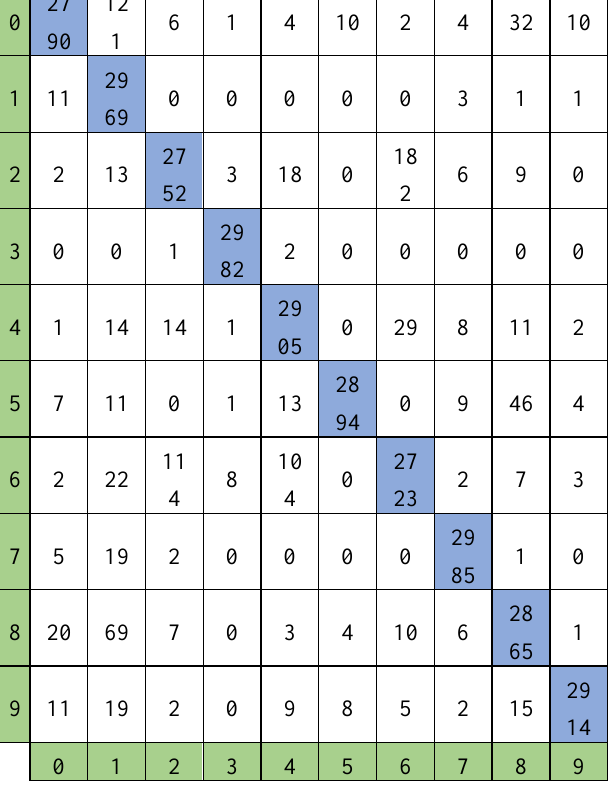
Fig. 7. Confusion matrix VGGNet16